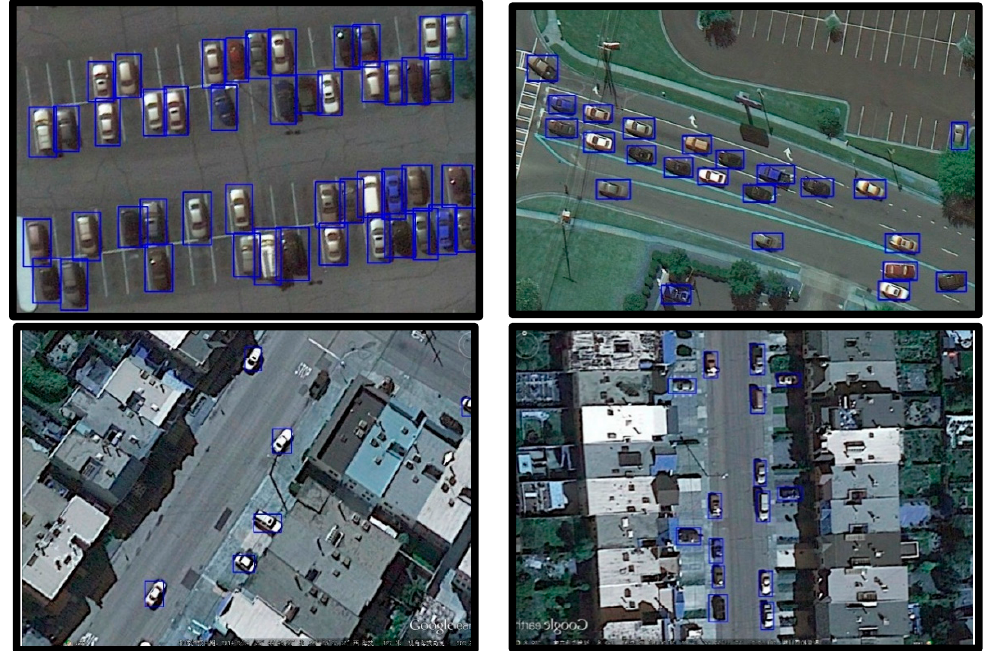
Figure 11. Detection samples on UCAS-AOD dataset using framework 1.2.